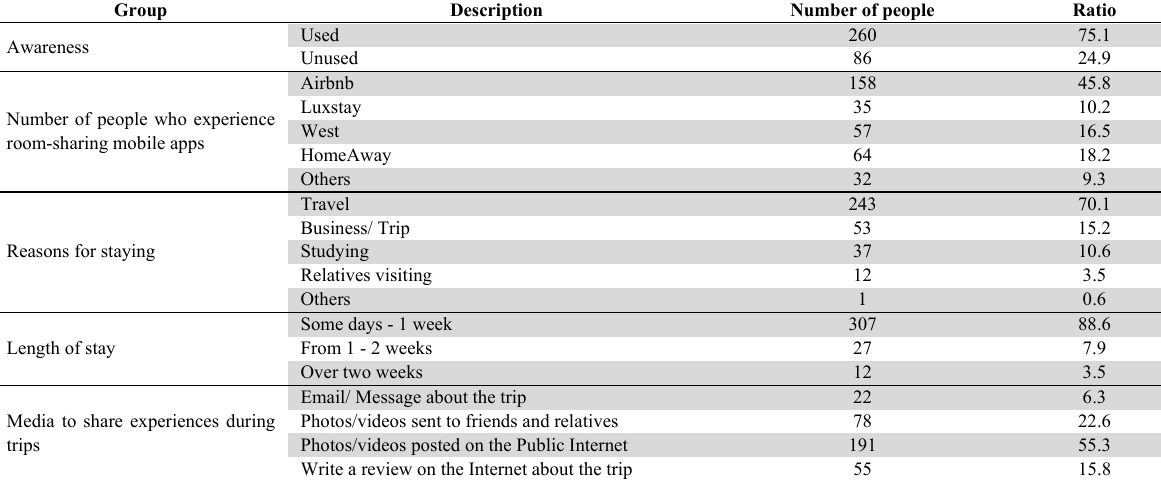
Customers’ characteristics of using mobile apps for